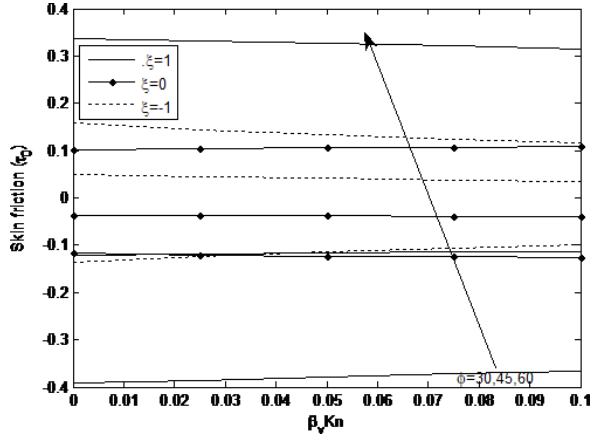
Fig. 8: Skin fraction ( τ 0 ) versus β v Kn for different of ϕ